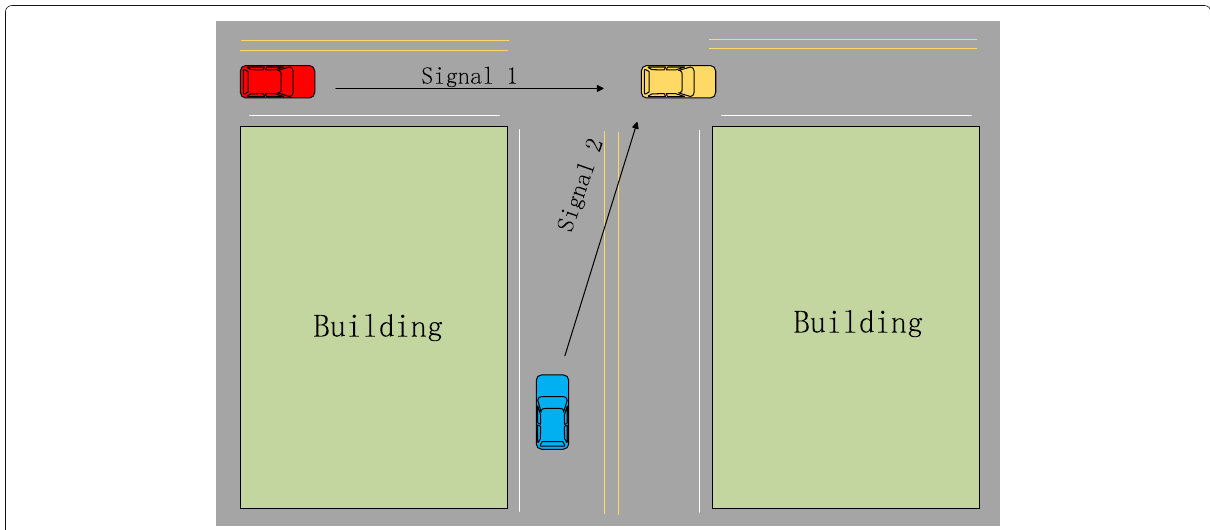
Fig. 2 The problem of hidden node due to existing buildings. Arrays in this figure represent signals